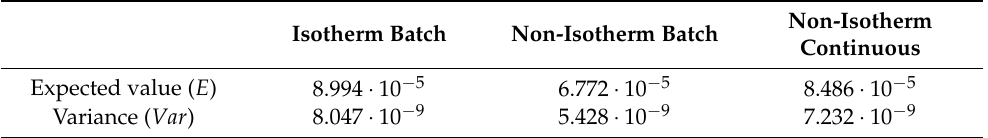
Table 4. The expected value and variance of the distribution in the three